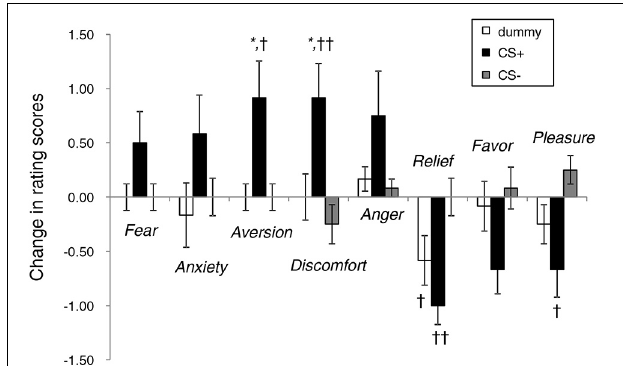
FIGURE 4 | Changes in the rating scores of emotional responses to neutral face stimuli before and after the conditioning experiments. ∗ p < 0 . 05 vs. a dummy; †† p < 0 . 01, † p < 0 . 05 vs. CS −